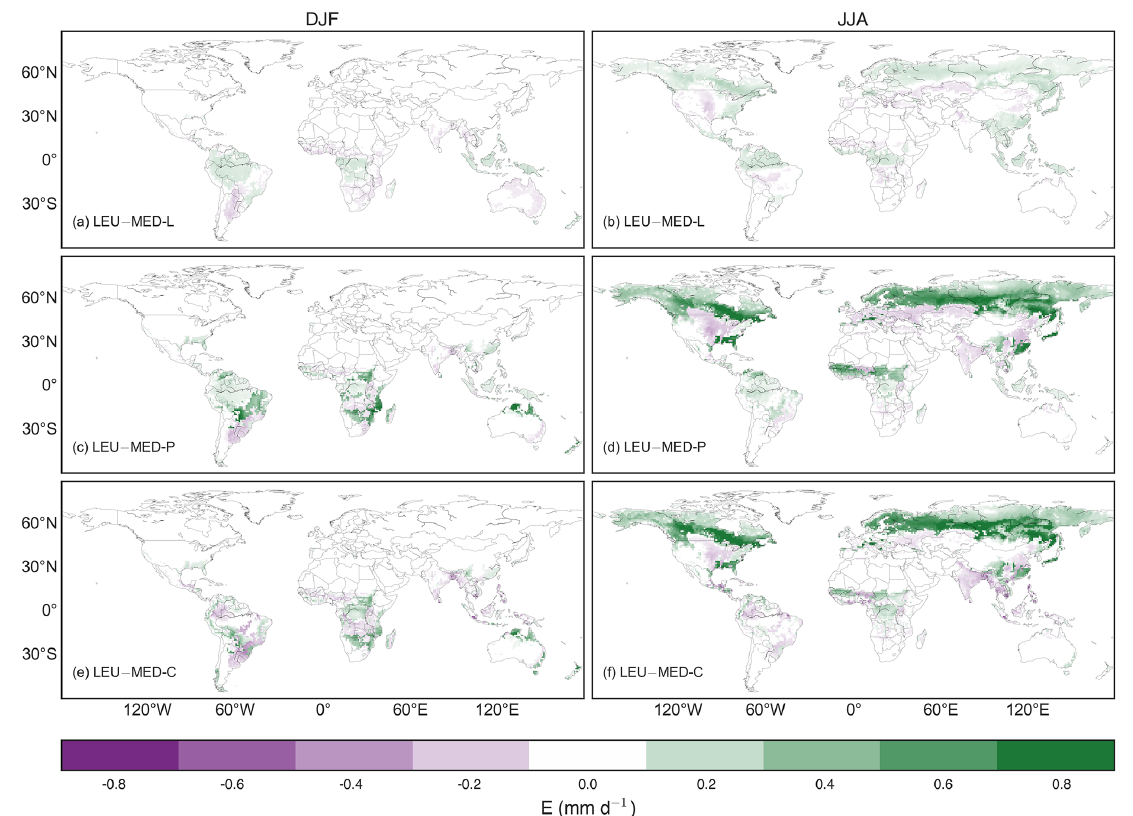
Figure 8. Mean seasonal (December-January-February: DJF and June-July-August: JJA) difference maps of transpiration ( E ) calculated across the 10 years of the Global Soil Wetness Project2 (GSWP-2) forcing (1986–1995) period. Panels (a) and (b) show the difference between the standard CABLE (LEU) model and the Medlyn model fit to the Leuning model (MED-L), panels (c) and (d) show the difference between the LEU model and the Medlyn model with the g 1 PFT parameterisation (MED-P), and finally, panels (e) and (f) show the difference between the LEU model and the Medlyn model with the g 1 parameter predicted as a function of climate indices (MED-C). In total, 126 out of a possible 54000 pixels have been masked from panels (e) and (f) , representing pixels where the temperature range and moisture index extended outside the range of the synthesis g s database. Data shown in panels (c) , (d) , (e) , (f) have been clipped, with the maximum ranges extending to ( − 0.3 to 1.12), ( − 0.33 to 1.27), ( − 0.63 to 0.84) and ( − 0.64 to 1.31) and this affects 36, 251, 8 and 444 pixels,